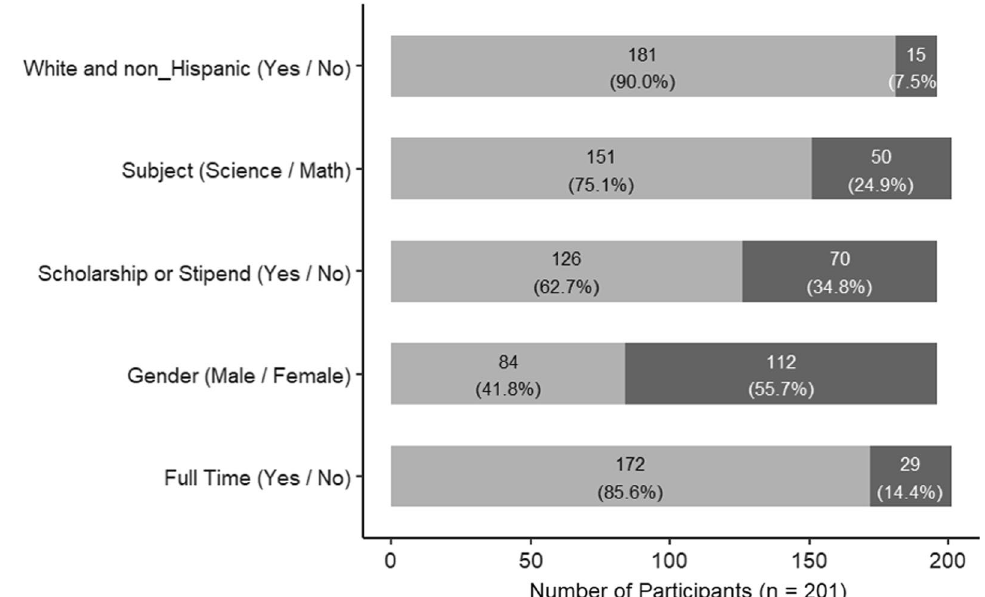
Fig. 3 Summary of early career teacher participant demographics ( n do not add to 100%, because five participants did not respond to these